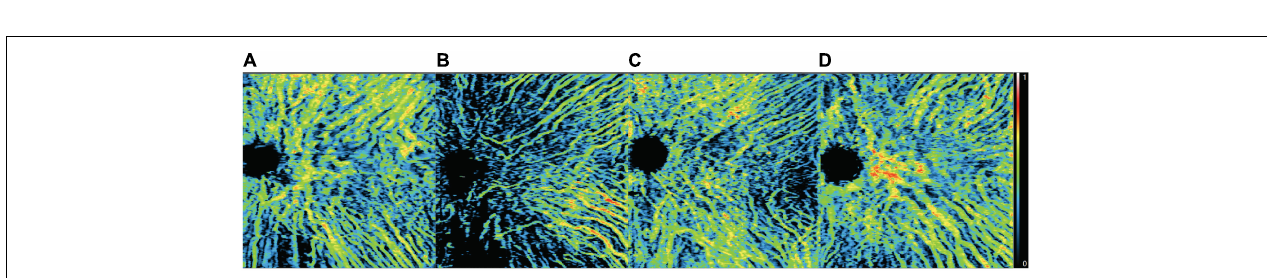
Frontiers in Medicine |